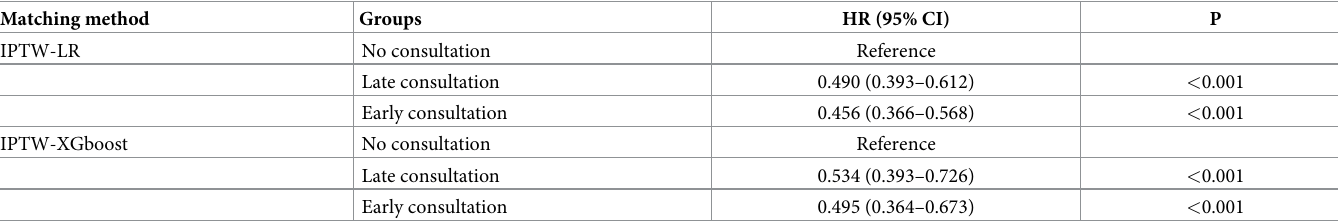
Table 5. Comparison of the mortality risk after propensity score